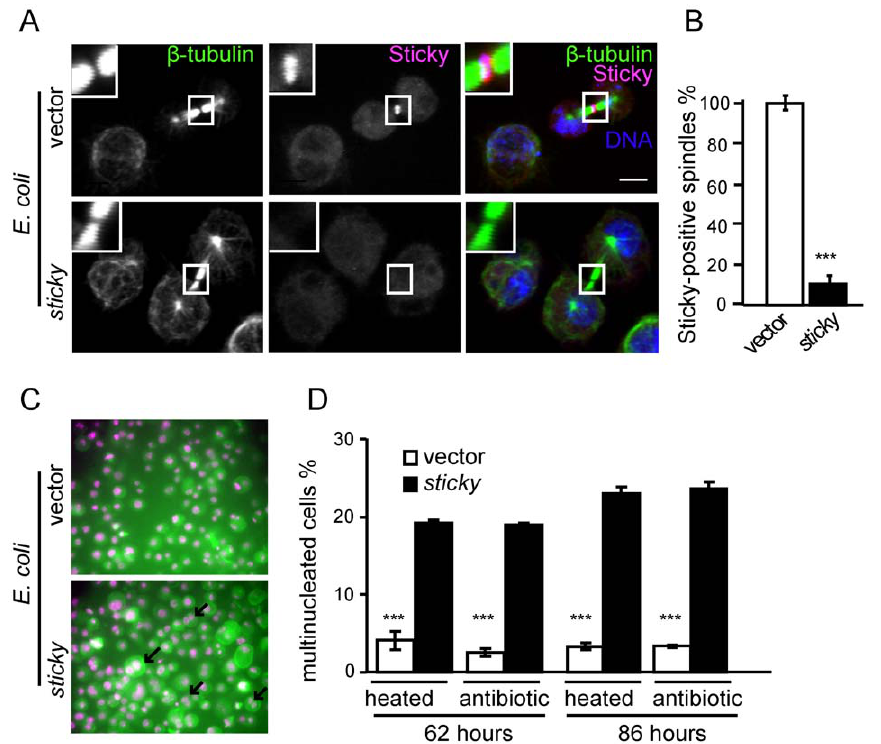
Figure 1. Knockdown of sticky expression by dsRNA-expressing E.coli . ( A ) S2 cells after 86 hours incubation with E. coli cells, stained for b - tubulin, Sticky and DNA (Hoechst-33342). Scale bar, 5 m m. Central spindle figures positive for Sticky were quantified in ( B ). ( C ) Incubation of S2 cells with E. coli that expressed sticky dsRNA increased the percentage of multinucleated cells in culture. Representative micrographs showing multinucleated S2 cells (e.g. arrows), cultured in the presence of E. coli that express sticky -dsRNA or carry pPD129.36 vector only (4), and stained with phalloidin (green) and the nuclear dye Hoechst-33342 (magenta). Cells were cultured for 62 or 86 hours in a 10-fold excess of IPTG-treated E. coli . To inhibit bacterial growth, E. coli cells were either heat-inactivated prior to incubation or cultured in the presence of antibiotics (penicillin and streptomycin). ( D ) Bar graph showing percentage of multinucleated S2 cells in cultures treated as ( C ). Values are averages of four independent experiments, each averaged from 200–500 S2 cells. Error bars indicate standard error of the mean. *** P , 0.005; two-tailed t-test. blots. Knockdown of either gene product did not affect the protein levels of the other, showing that RNAi was specific to the gene product targeted (Fig. 2C, D). Identical amounts of bacteria produced different levels of protein knockdown for each gene